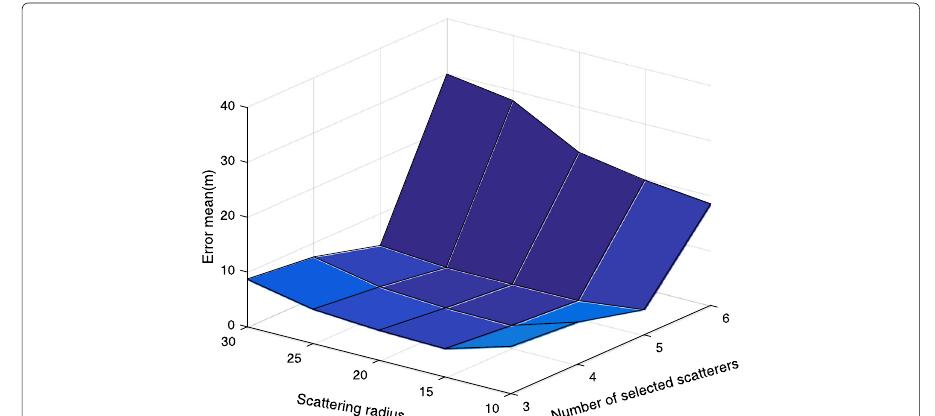
Fig. 8 Influence of the number and size of scattering areas on positioning performance